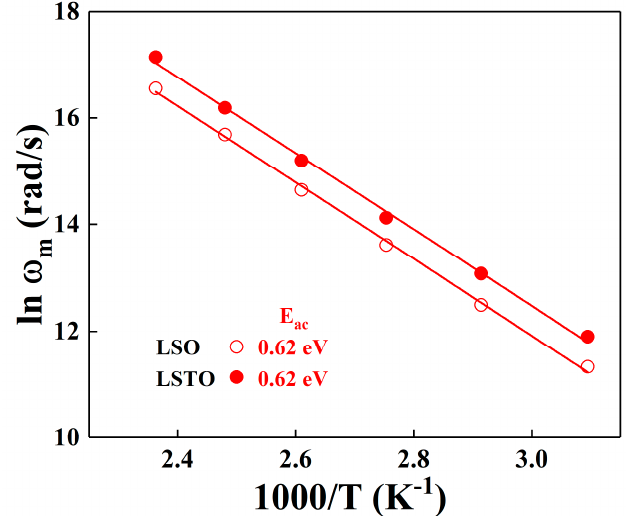
Figure 7. Temperature dependence of the ac conductivity, which is fit from the dielectric relaxation peak frequency ω m , obtained from the modulus analysis for LSO (opened symbols) and LSTO (closed symbols) glasses. The solid lines are the least ‐ squares straight ‐ line fits to the data.